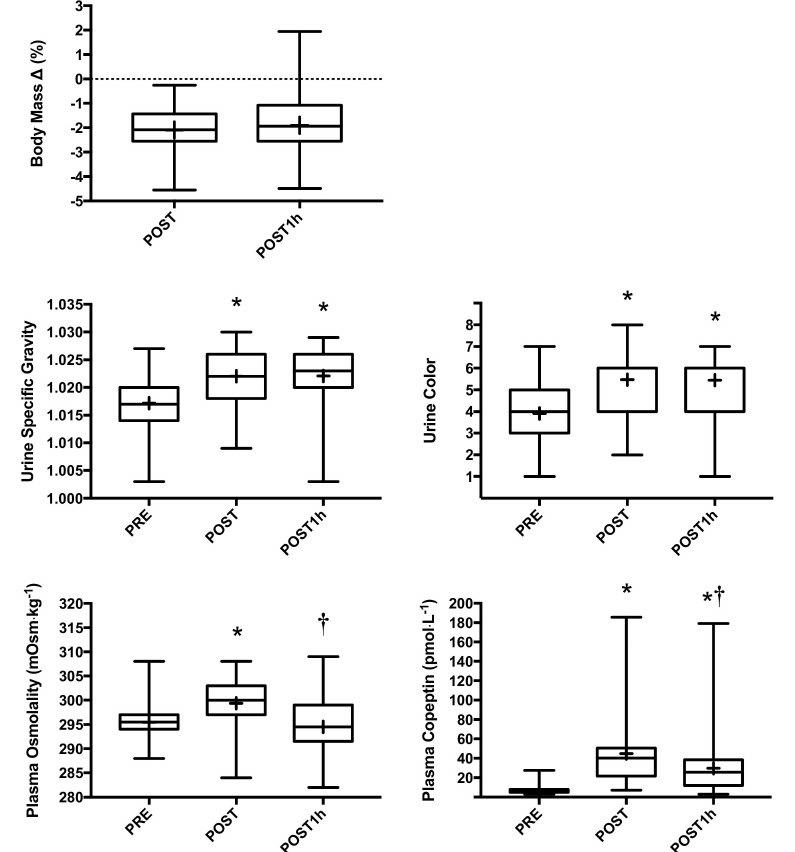
Figure 1. Summary statistics for hydration biomarkers before (PRE) and following the 161 km cycling ride (POST), and one hour after consuming the 650 mL water bolus (POST1h). * represents statistical di ff erence from PRE and † from POST; + represents the time point mean.